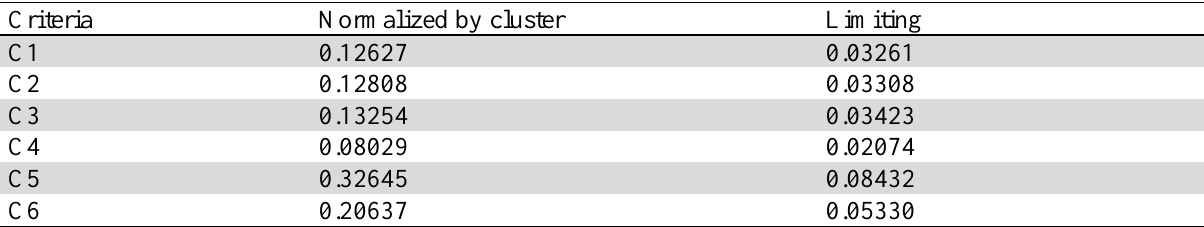
ANP priorities list Criteria Normalized by cluster